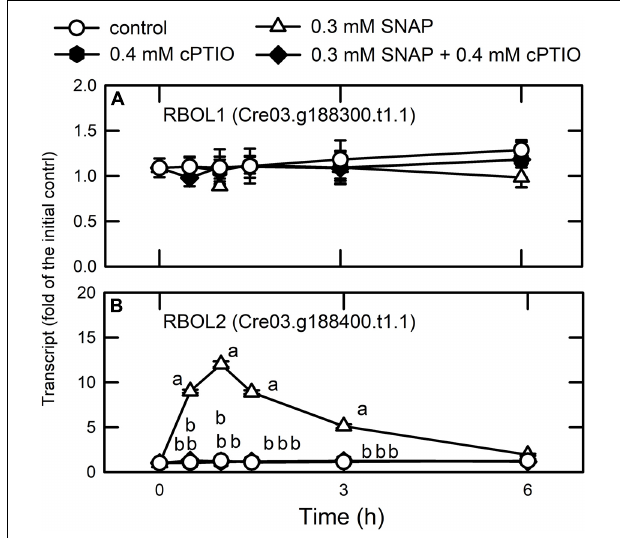
FIGURE 11 | Effects of NO on the expression of genes encoding NADPH oxidase. Time-course changes in the transcript abundances of RBOL1 (A) and RBOL2 (B) in C. reinhardtii after exposure to 0.3 mM SNAP in the presence or absence of 0.4 mM cPTIO. Data are expressed as the mean ± SD ( n = 3). Different symbols indicate significant differences between treatments (Scheffe’s test, P < 0.05).